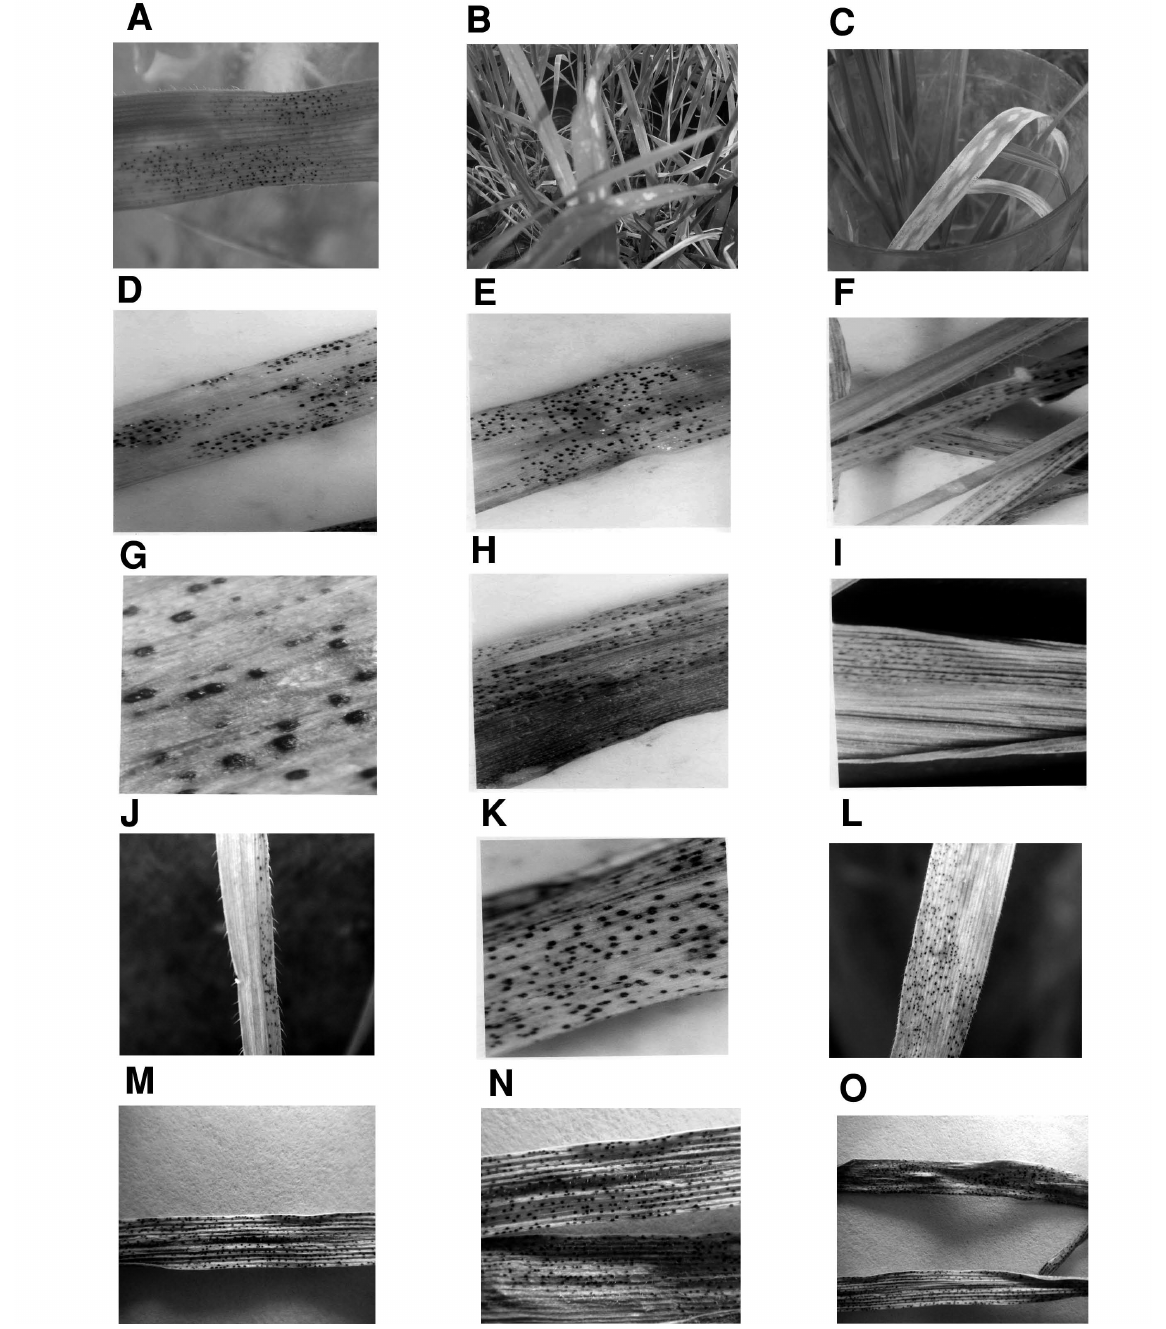
Figure 1. Symptoms of infected plants inoculated at the 3rd leaf stage with various Septoria species under greenhouse conditions. A, B, C. Septoria tritici on Triticum aestivum 15 days after inoculation (d.a.i) . D. S. passerinii on Hordeum vulgare 60 d.a.i. E. S. passerinii on H. distichon 60 d.a.i. F. Septoria cf. koeleriae on Lophochloa phleoides 21 d.a.i. G, H. S. phalaridis on Phalaris paradoxa . 60 d.a.i. I. Septoria sp. 2 on Lolium loliaceum . 15 d.a.i. J. Septoria sp. 1 on Aegilops tauschii . 60 d.a.i. K, L. S. halophila on H. glaucum . 20 d.a.i. M. S. tritici on T. dicoccum 15 d.a.i. N, O. S. tritici on T. compactum 15